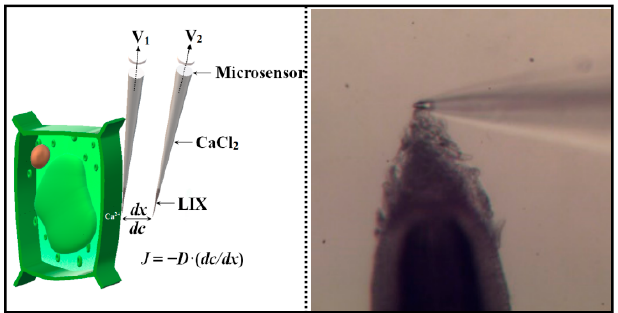
Figure 2. Schematic diagram and measured photo of Ca 2+ flux analysis by non-invasive micro-tests. The diagram is to demonstrate the principles behind NMT testing and is not to scale. The tip diameter of the microsensor is about 5 μ m.